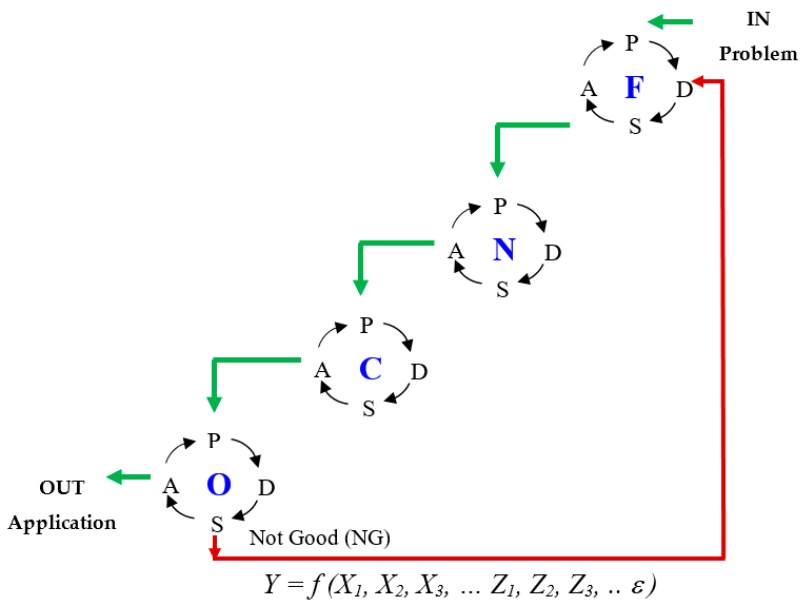
Figure 11. F-N-C-O ladder for measurement system in robust design engineering.